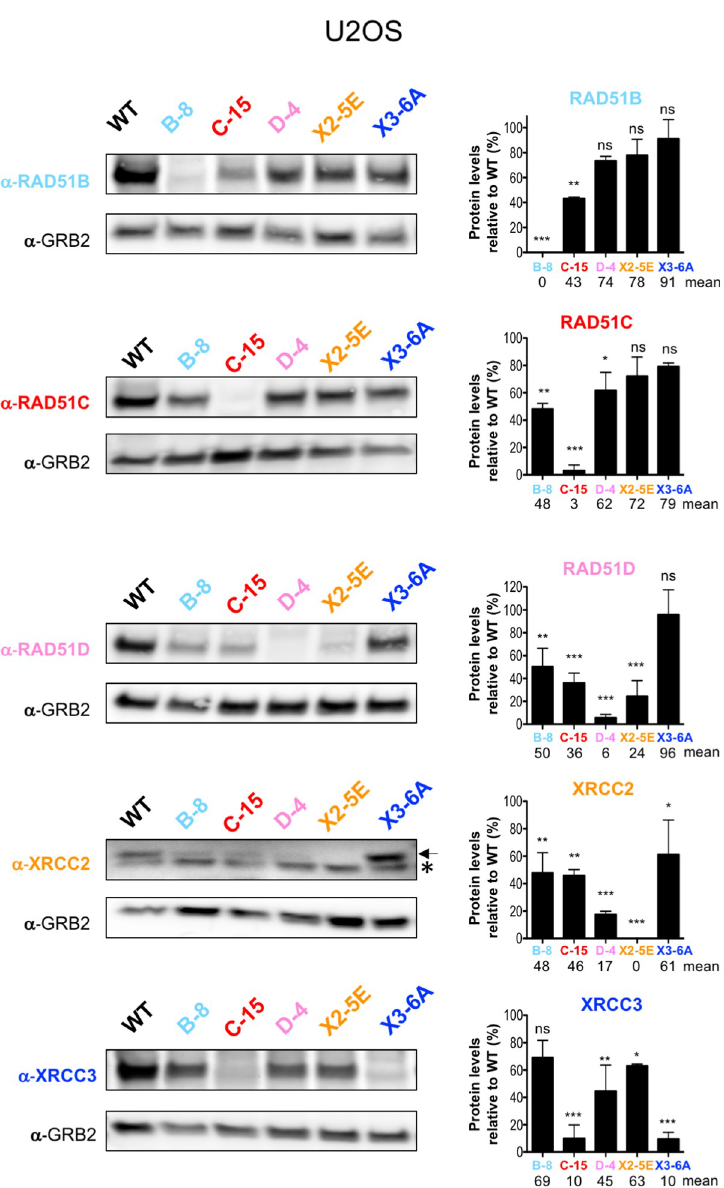
Fig 6. RAD51 paralog protein levels in mutants. Immunoblots of crude cellular extracts from wild-type cells and mutant U2OS cells. GRB2 was used as loading control. Arrow indicates XRCC2 specific band whereas � indicates a non-specific band. The intensities of RAD51 paralogs protein bands were normalized to the GRB2 signal and the quantification is expressed in relative % to the levels detected in wild-type cells. Differences between protein levels detected in mutant versus wild-type cells were statistically analyzed using unpaired one-way ANOVA and Tukey’s test. � p < 0.05, �� p < 0.01, ��� p < 0.001, ns not